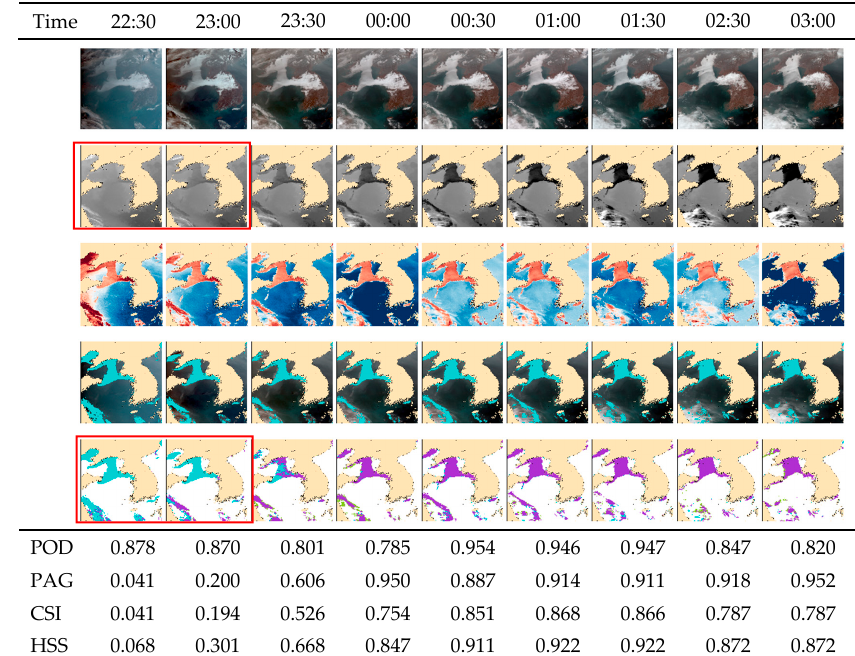
Figure 13. Temporal variation of sea fog on 13 March 2018, at 22:30 UTC to 14 March 2019, at 03:00 UTC with 30-min intervals in an RGB image, the brightness temperature at 3.9 µ m, NDSI obs − NDSI cal , results for sea fog detection, and the statistical comparison between two sea fog algorithms.